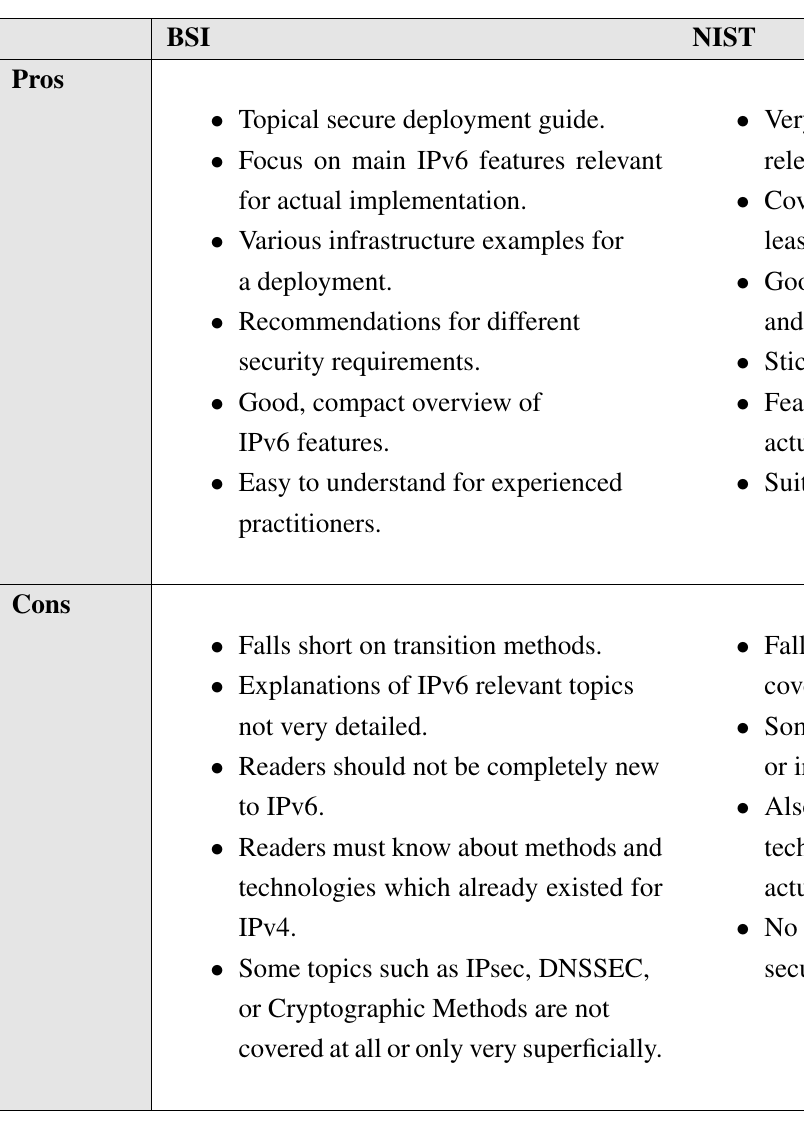
Table 12. Pros and cons of the